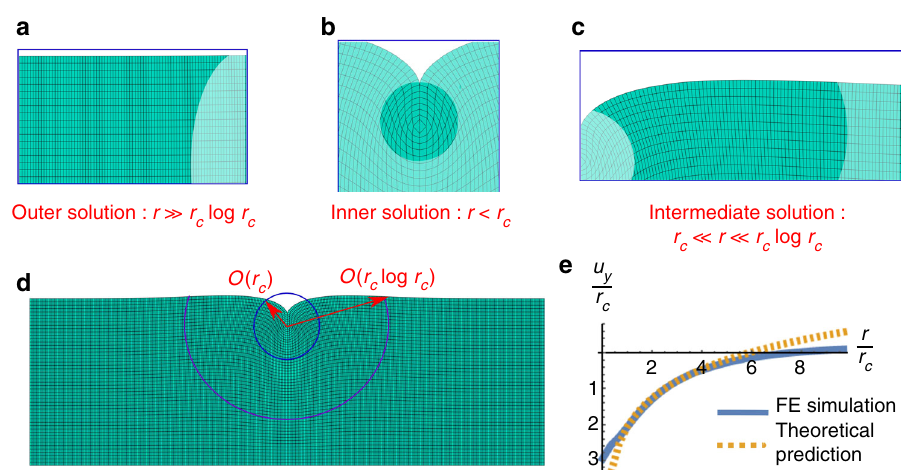
Fig. 3 Finite element simulations. Results of the mixed fi nite element simulation of an elastic slab of initial unit thickness displaying a crease with radius r c ¼ 0 : 04 and depth h ¼ 2 r c at an axial compression just beyond the nucleation threshold, i.e., λ x ¼ 0 : 63. The outer, inner and intermediate solutions are depicted in a – c , highlighting the respective range of validity in the asymptotic analysis. The overall deformed shape of the elastic slab is shown in d , with indication of the underlying mesh. In e , the numerical near- fi eld vertical displacement (blue solid line) is fi tted by the theoretical prediction of Eq. (18) (dashed orange line) without any adjustable parameter